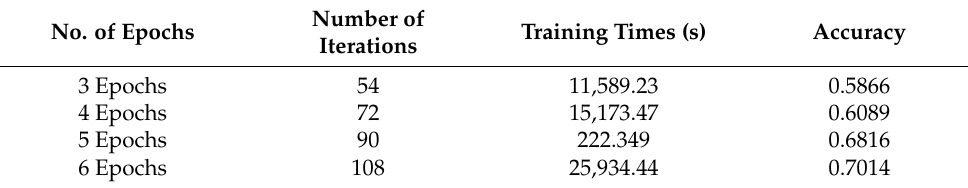
Table 6. MiniBatchsize training results for the value of 10. Table 5. MiniBatchsize training results for the value of 60.